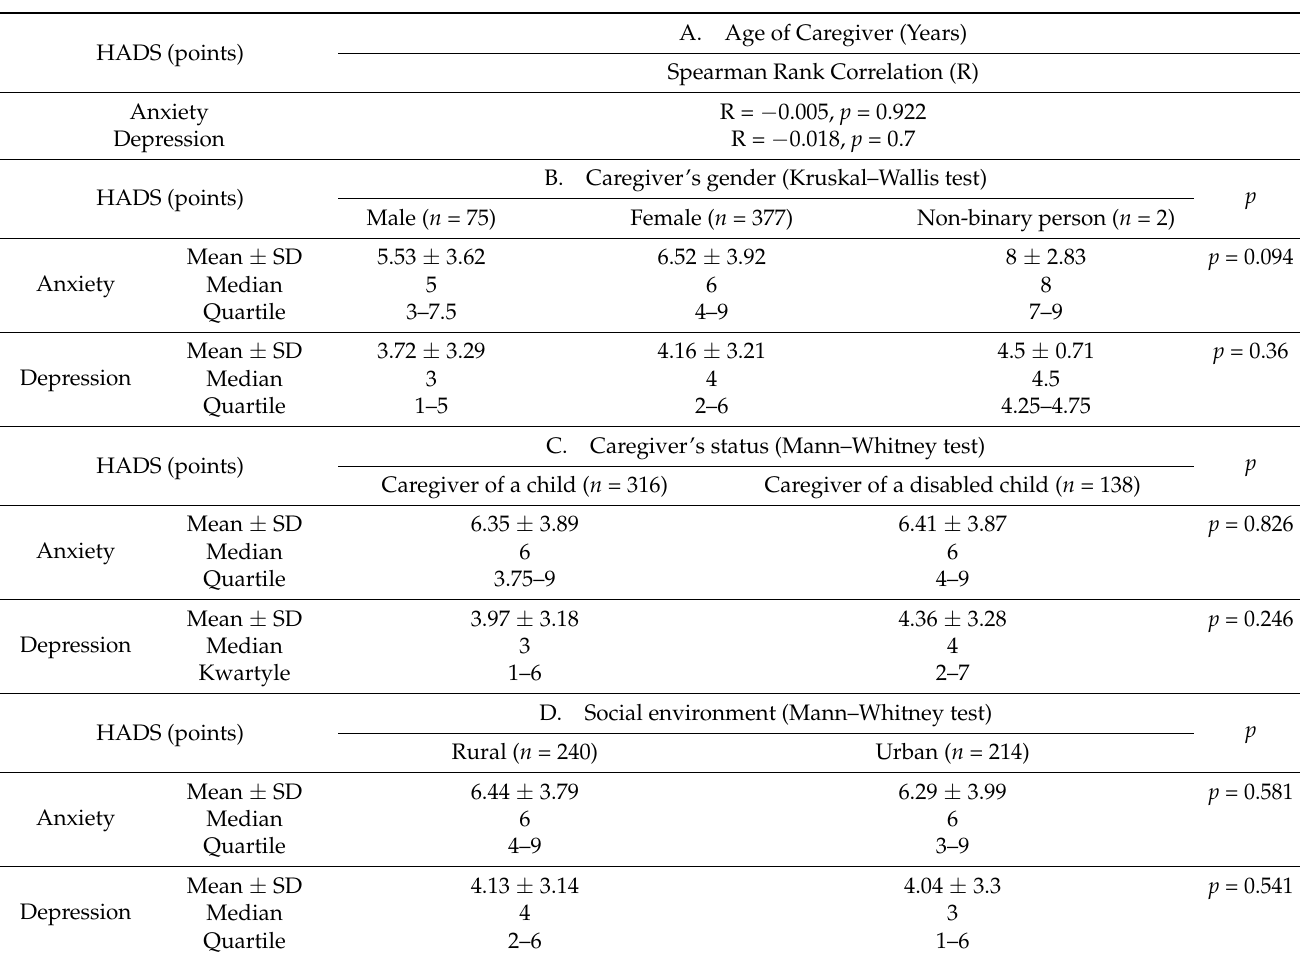
Table 7. Age (A), gender of the caregiver (B), status of the caregiver (C), social environment (D) and the level of anxiety and depression.